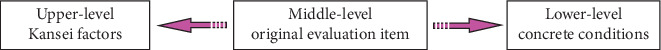
Evaluation grid diagram.